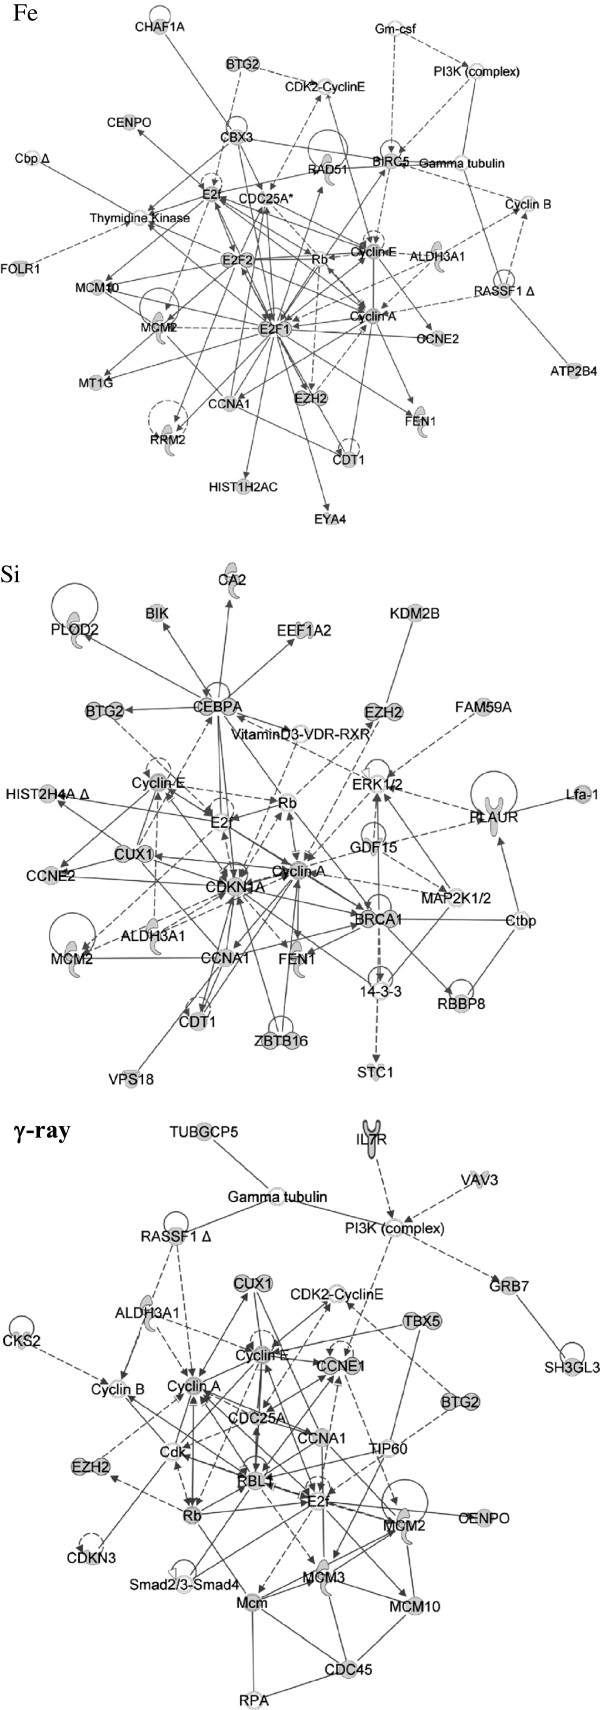
Gene interaction networks associated with radiation types. Highest rated gene interaction networks for differentially expressed genes after exposure to 56Fe or 28Si particles or γ-rays. Nodes with grey color identify significantly changed genes after radiation.